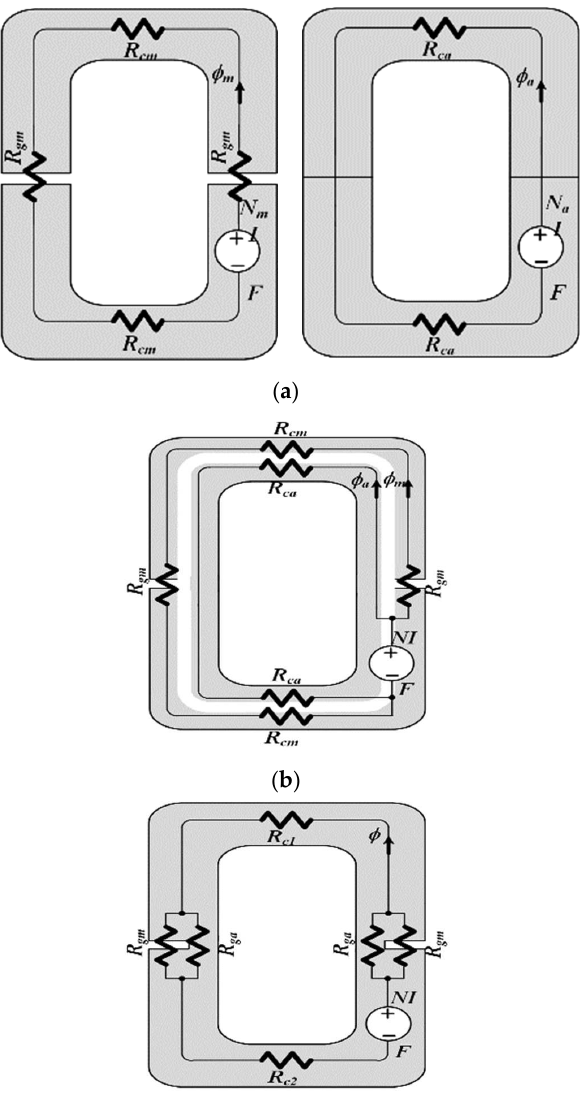
Figure 5. Heterogeneous reactor implementation method. ( a ) Two independent reactor series configuration; ( b ) Two independent magnetic circuits in one magnetoelectric circuit; ( c ) One magnetic circuit in one magnetoelectric circuit